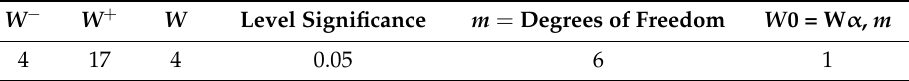
Table 9. Parameters for the statistical